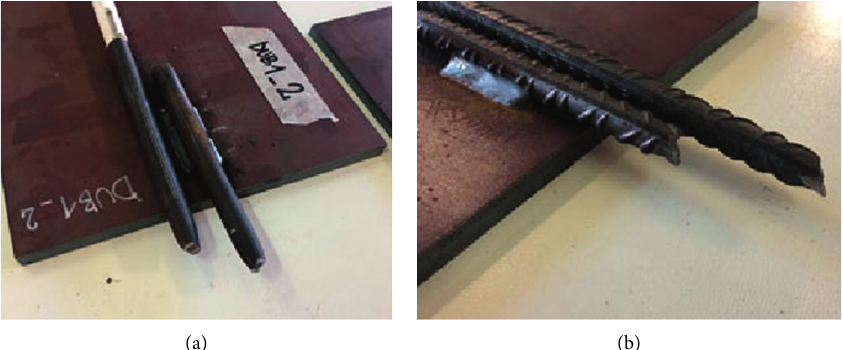
Figure 8: Failure of small-diameter Dub joints (smooth sample (a) and ribbed sample (b)). Failure always happens in correspondence of the rebar for values comparable to the ones achieved from tensile tests on the unwelded samples.